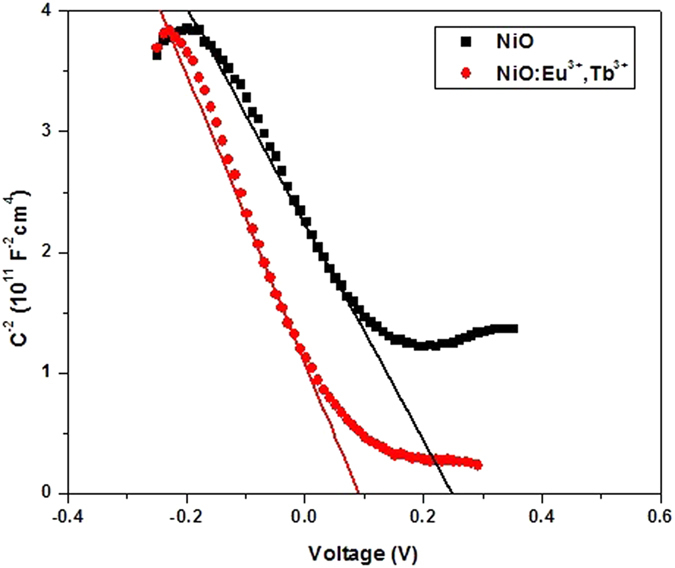
MS plots of (a) NiO and (b) NiO:Eu3+,Tb3+ in 0.5 M Na2SO4 electrolyte.